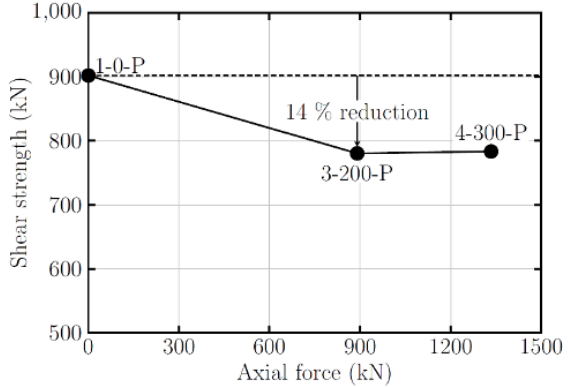
Figure 7. Shear strength dependence on applied ax- ial